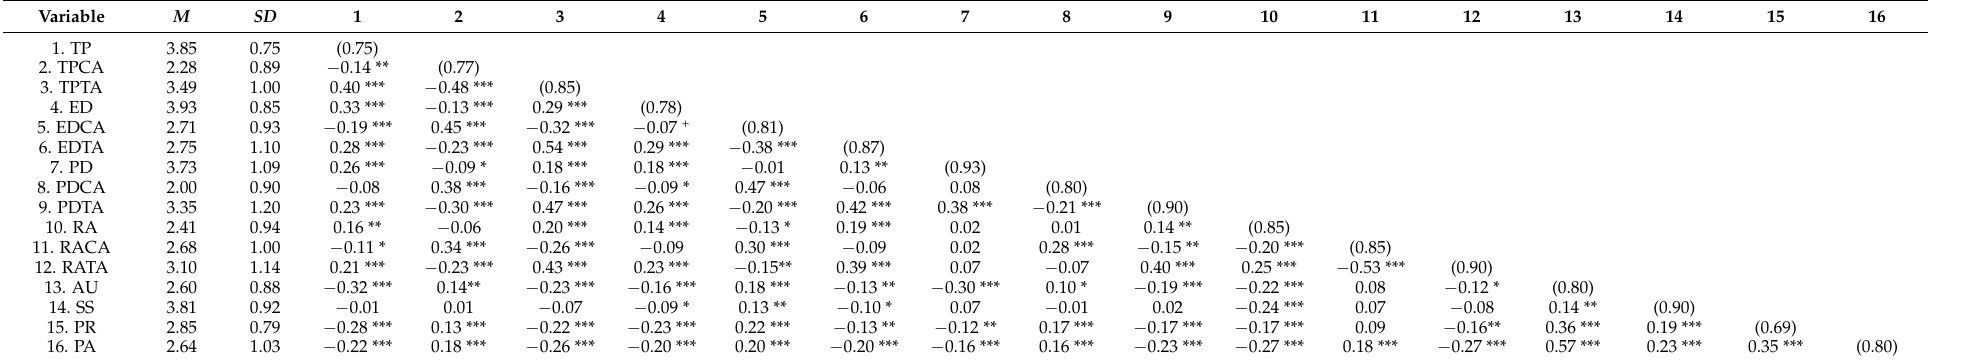
Table 3. Means, standard deviations, reliabilities (Omega), and correlations for study